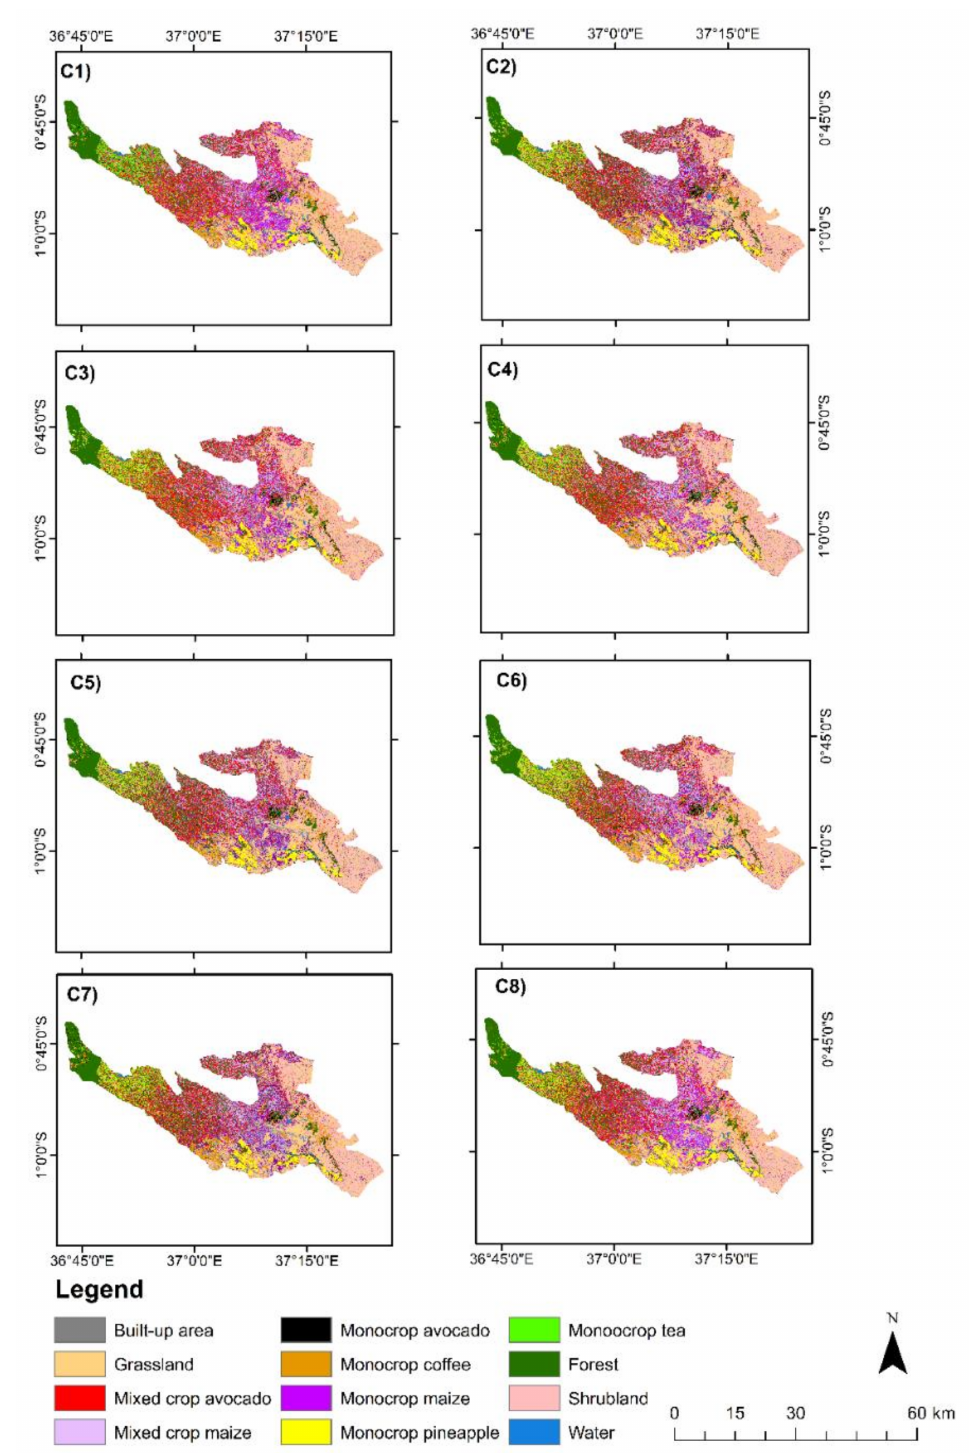
Figure 4. Cropping pattern and non-cropland maps produced using the guided regularized random forest-selected variables of each classification scenario (C1–C8) and the random forest classifier. C1 = Sentinel-2 reflectance bands, i.e., S2 bands; C2 = S2 bands and vegetation indices (VIs), i.e., S2 bands and VIs; C3 = S2 bands and vegetation phenology (VP), i.e., S2 bands and VP; C4 = S2 bands and Sentinel-1 (S1) backscatter data, i.e., S2 bands and S1; C5 = S2 bands, VIs and S1; C6 = S2 bands, VP and S1; C7 = S2 bands, VIs, and VP; and C8 = S2 bands, VIs, VP and